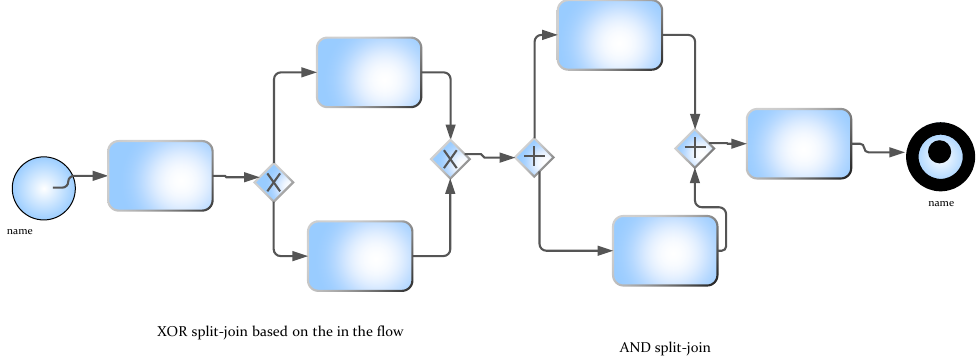
Figure 10. Some examples of possible constructions of information and control flow of Business